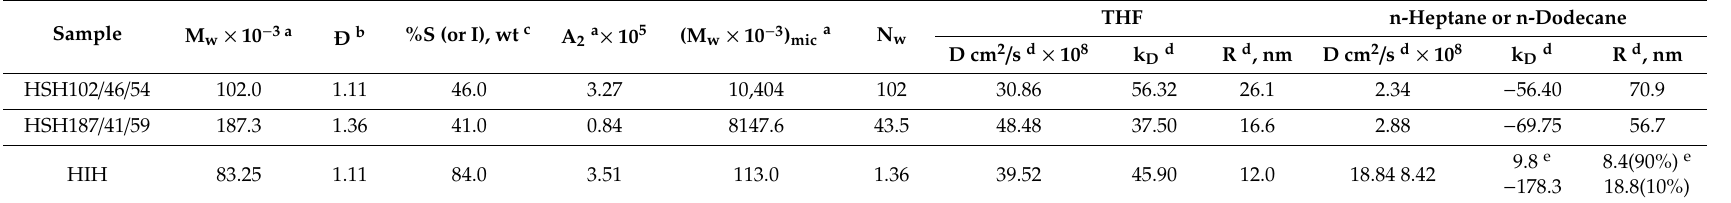
Table 3. Molecular characteristics of the HSH and HIH triblock copolymers and their micellar characteristics in n-heptane and n-dodecane, respectively.